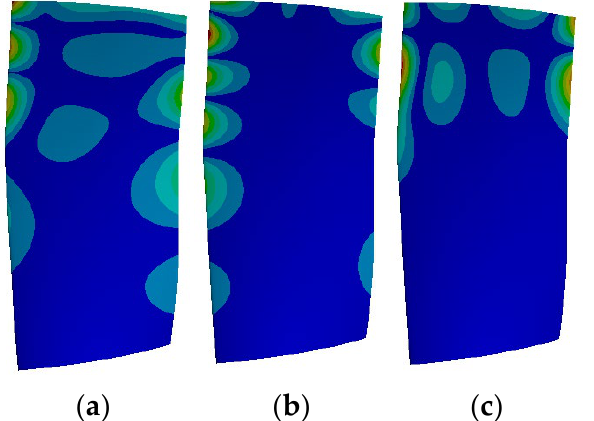
Figure 29. Modal shape of R1 rotor blade near 45 EO frequency. ( a ) Mode 20 ( b ) Mode 21 ( c ) Mode 22.